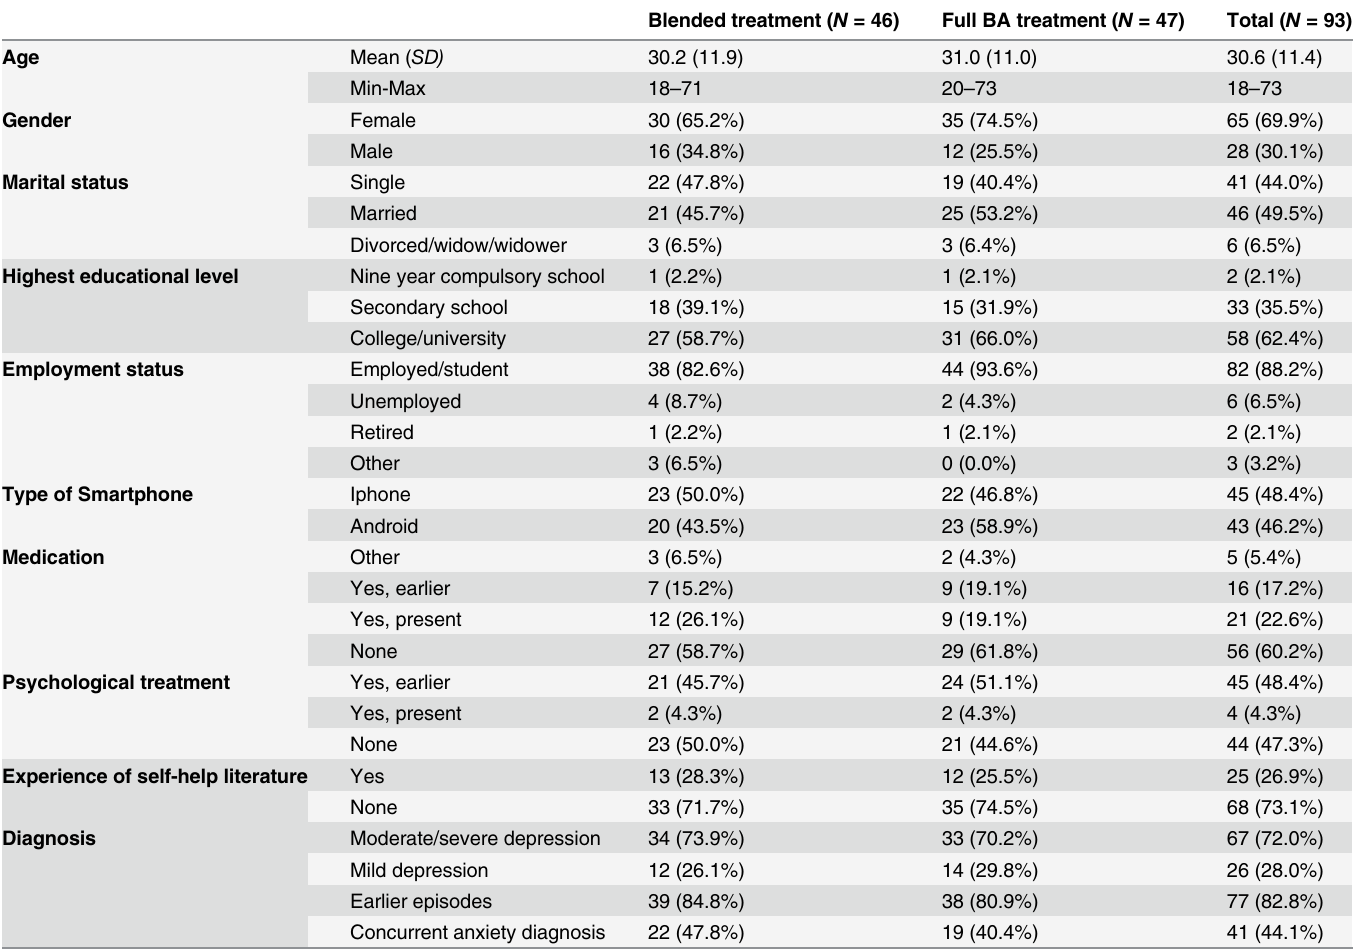
Table 1. Demographic description of the participants at